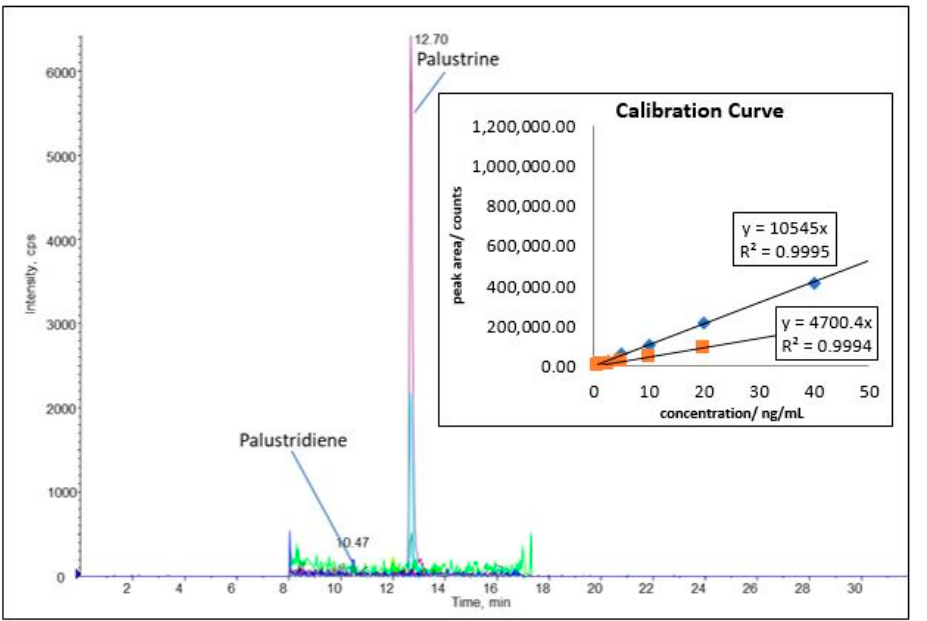
Figure 4. A typical HPLC-MS/MS chromatogram for E. palustre showing traces of palustridiene and larger amounts of palustrine. The calibration curve features the standards of palustrine ( m / z 310.100 → 154.200) and palustridiene ( m / z 294.000 → 157.200).